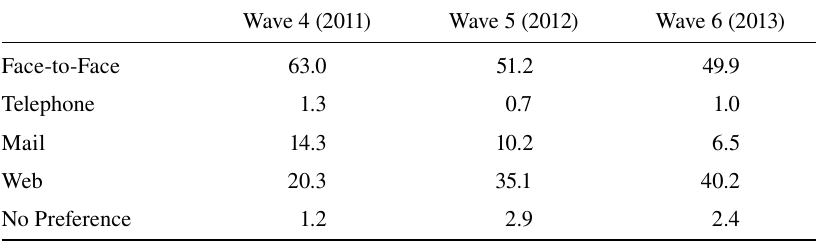
Mode Preference by Wave (in